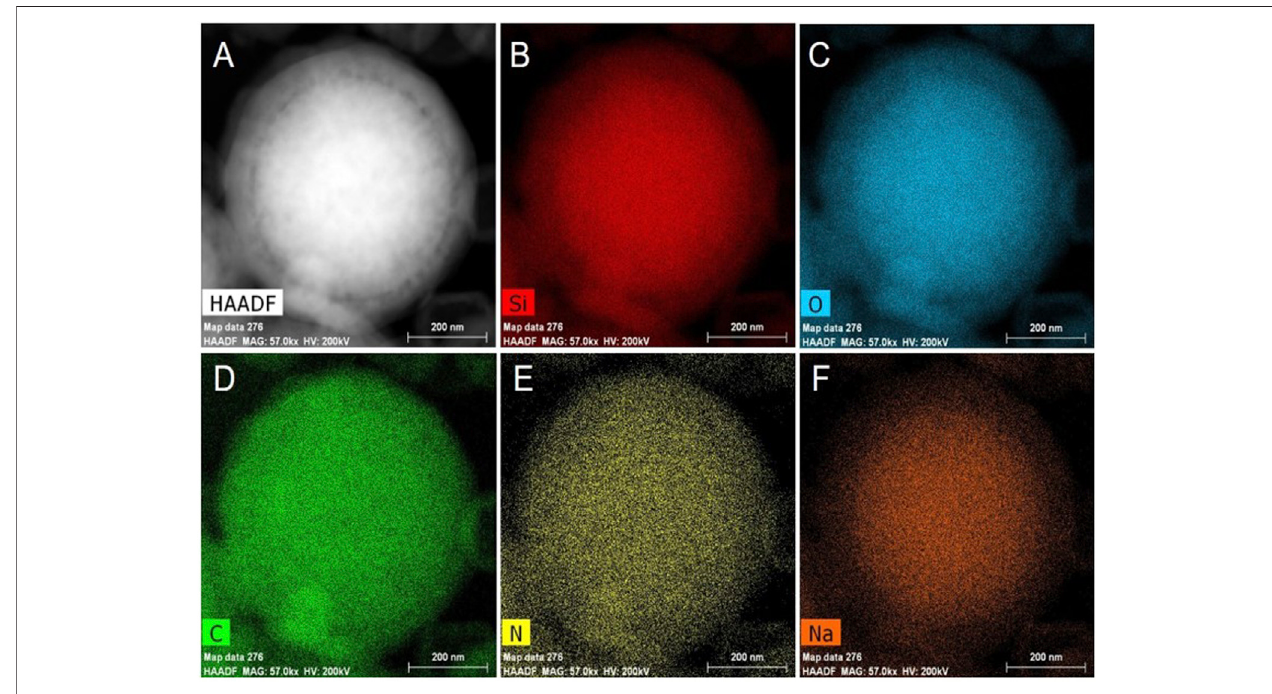
FIGURE 6 | (A) HAADF-STEM image and element mapping of m SiO 2 : (B) Si element, (C) O element, (D) C element, (E) N element and (F) Na element.